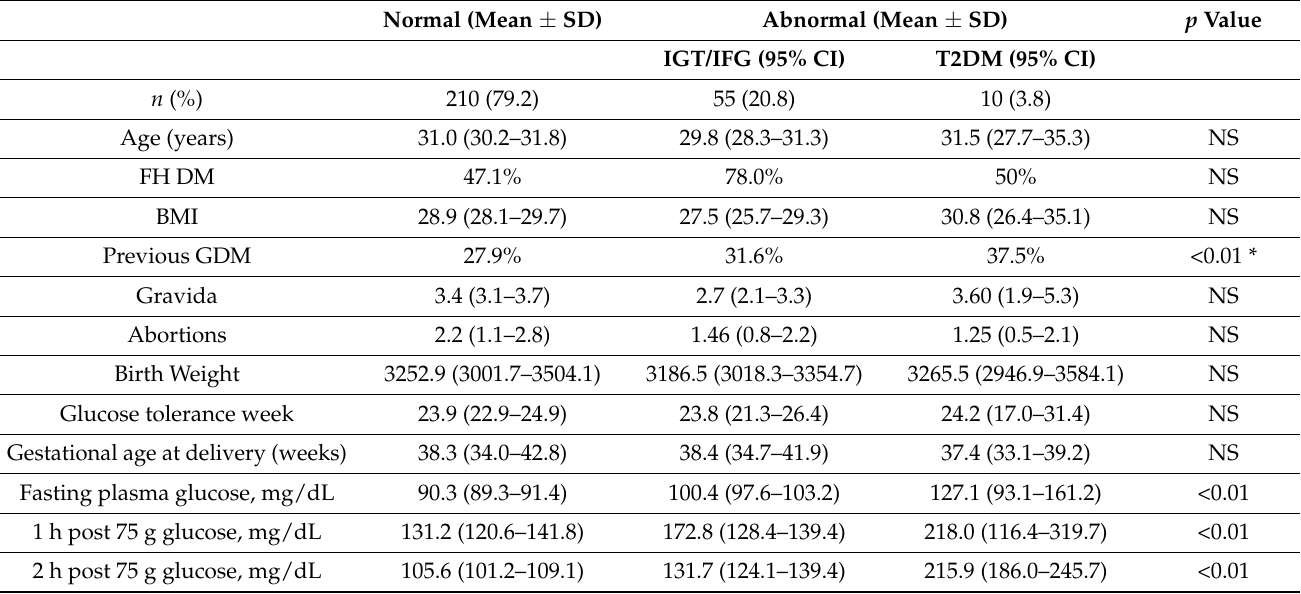
Table 2. Comparison of women ( n = 265) with normal OGTT, impaired OGTT (IGT/IFG) and those with significantly impaired OGTT